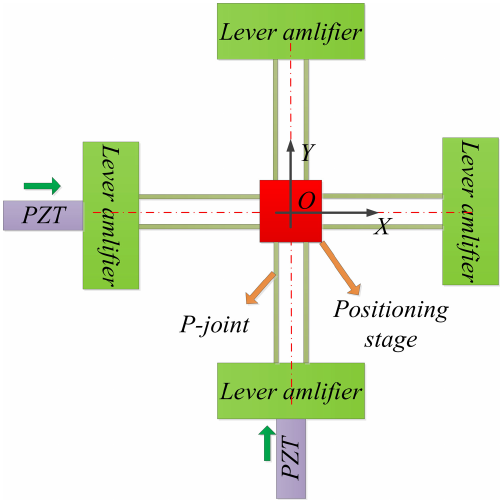
Figure 5. The 3-D diagram of the 2-DOF compliant